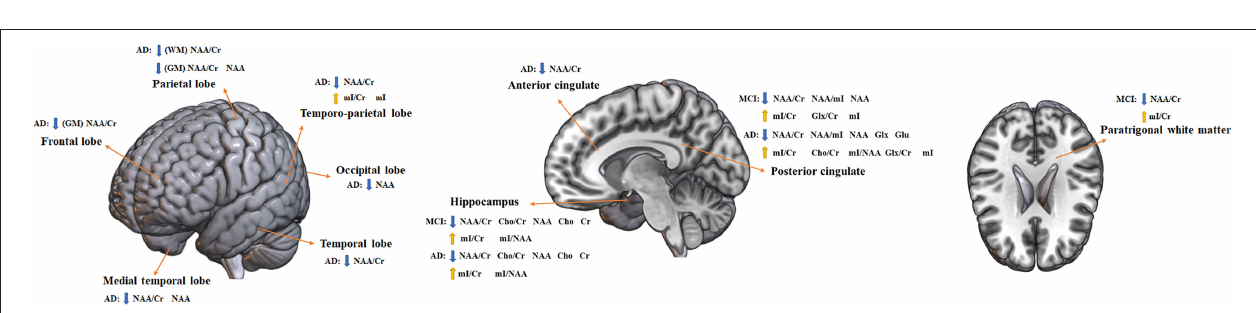
FIGURE 9 | Altered metabolites in MCI and AD brain structures. AD, Alzheimer’s disease; MCI, mild cognitive impairment; WM, white matter; GM, gray matter; NAA, N-acetyl aspartate; Cr, creatine; mI, myo-inositol; Cho, choline; Glx, glutamate + glutamine; Glu, glutamine. Directions: down, decrease; up, increase.